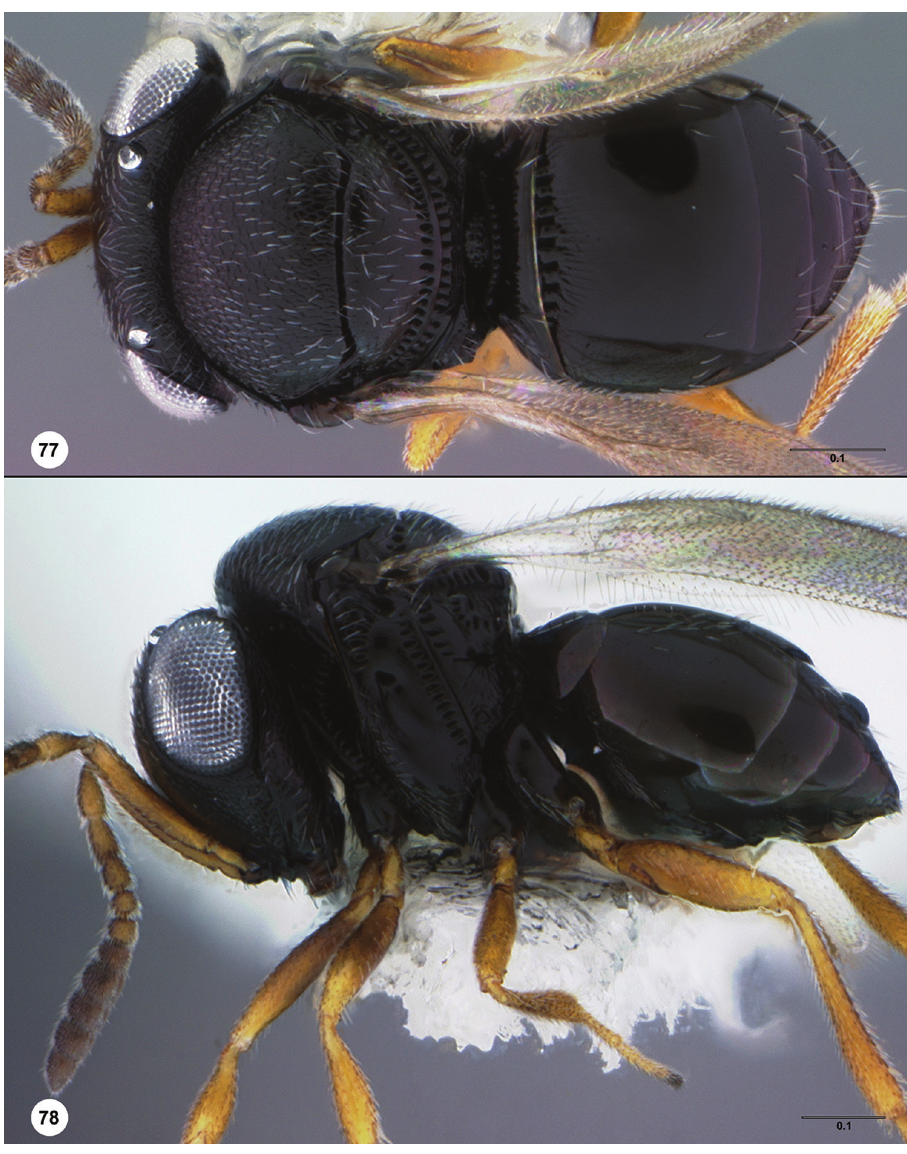
Figures 77–78. T. hyalinipennis 77 female (USNMENT01109062), head, mesosoma, metasoma, dorsal view 78 female (USNMENT01109060), head, mesosoma, metasoma, lateral view. Scale bars in millimeters. dorsally. Macrosculpture of anteroventral mesopleuron: absent. Postacetabular sulcus: formed by large cells. Mesopleural epicoxal sulcus: formed by small punctures. Meso- furcal pit: absent. Setation of posteroventral metapleuron: absent. Sculpture of dorsal metapleural area: smooth. Posterodorsal metapleural sulcus: present as line of foveae. Paracoxal sulcus in ventral half of metapleuron: absent. Anteroventral extension